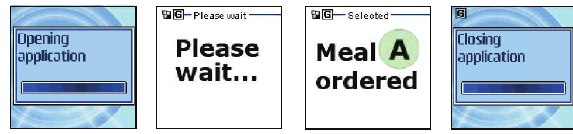
Figure 5: Feedback texts of a mobile phone after touching a